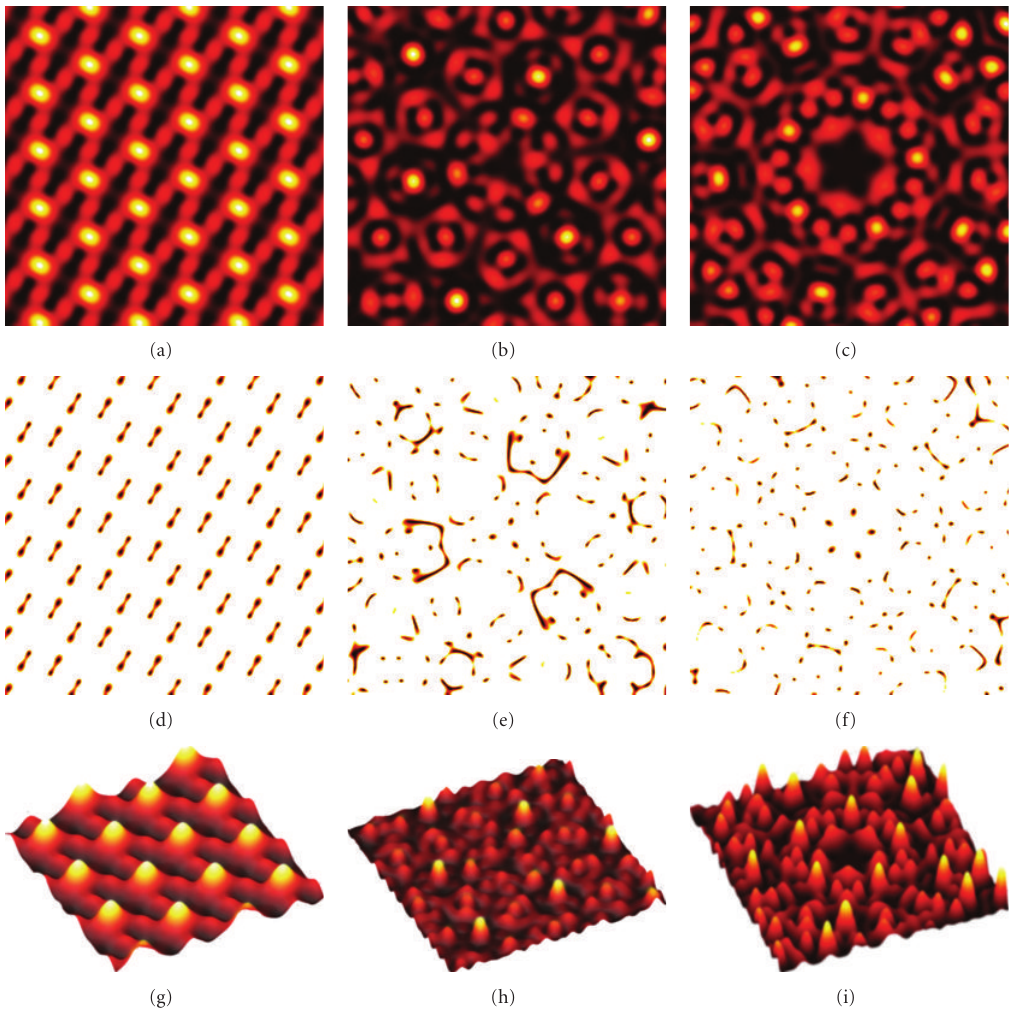
Figure 6: Computational analysis of complex 3D complex vortex lattices. Taking the multiples of relatively phase-shifted three beams, where the numbers of interfering beams involved are, respectively, 6 + 1 beams (first column), 9 + 1 beams (second column), and 15 + 1 beams (third column). (a)–(c) Intensity distribution in x - y plane. (d)–(f) Intensity distribution with a lower threshold value in order to highlight the darker regions alone. (g)–(i) Intensity mesh